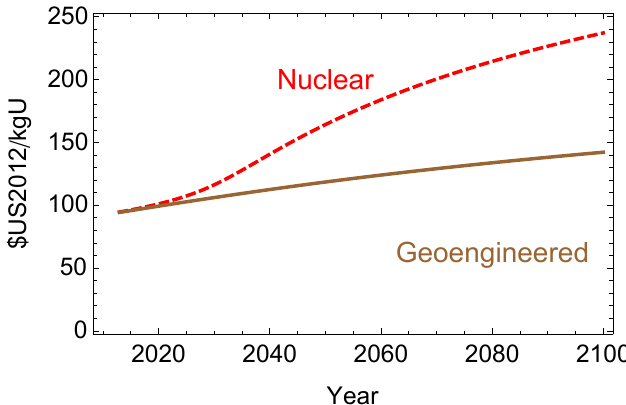
Figure 4. Uranium price with nuclear-led decarbonization (dashed curve), versus a geoengineeered outcome with stratospheric sulfur injection along with subsequent extensive carbon sequestration (solid